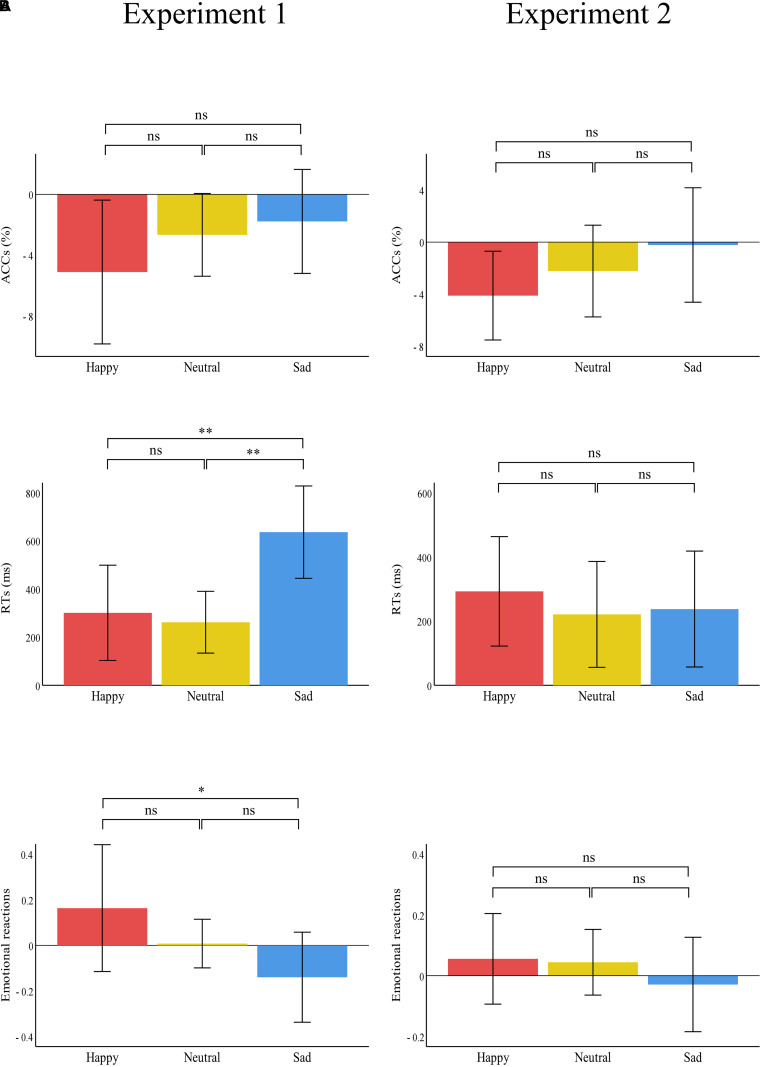
Bar charts representing the results of the one-way ANOVAs of the difference values between the two treatments (painful–control). RTs (top panel), ACCs (middle panel), and emotional reactions (bottom panel) for happy (red), neutral (yellow), and sad (blue) pictures in (A) Experiment 1 and (B) Experiment 2. Data are expressed as mean ± SEM. ns: p > 0.05; *p < 0.05, **p < 0.01.